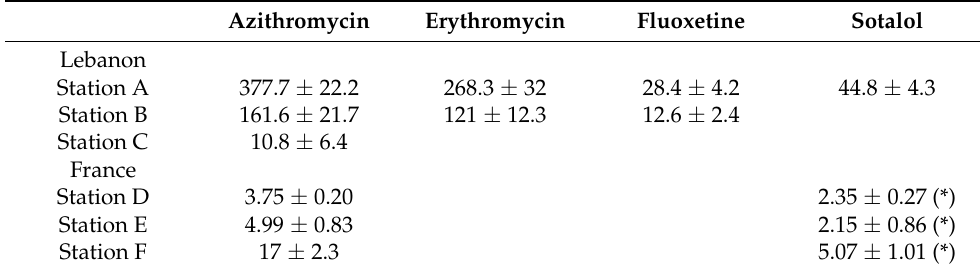
Table 4. Levels of pharmaceuticals found in France and in Lebanon (ng L − 1